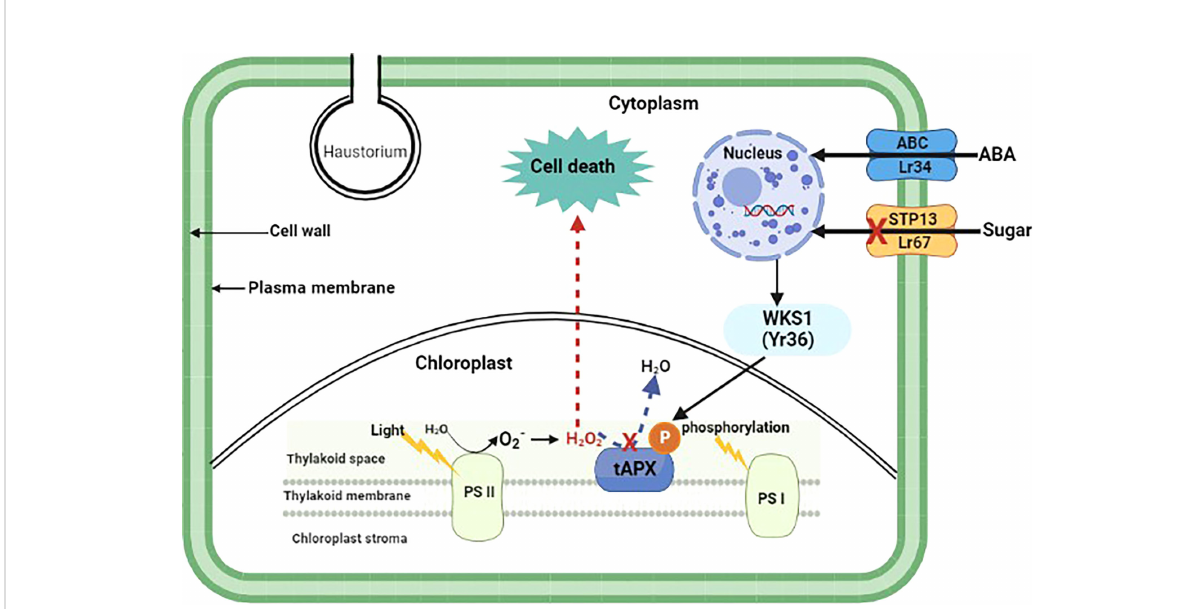
FIGURE 1 Proposed model of adult plant resistance gene function. Pathogen-speci fi c ( Yr36 ) and multi-pathogen ( Lr34 and Lr67 ) adult plant resistance genes and their involvement in plant cell signaling and defense pathways. Yr36, a wheat kinase START1 (WKS1) protein, mediates resistance to wheat stripe rust through phosphorylation of photosystem II manganese-stabilizing polypeptide protein complex (PsbO) found in the chloroplast thylakoid membrane. Phosphorylated PsbO is rapidly degraded by proteases, yielding PsbO-free PSII, which has a lower photosynthesis rate and serves as a source of O − 2 , which is then converted to H 2 O 2 . Due to WKS1-mediated phosphorylation, H 2 O 2 cannot be effectively destroyed by thylakoid ascorbate peroxidase (tAPX) and it accumulates, inducing cell death which curbs Pst growth. Lr34 and Lr67 are adenosine triphosphate-binding cassette (ABC) and sugar transporter (STP) proteins that confer multi-pathogen resistance through regulation of abscisic acid (ABA) and hexose sugar molecules,